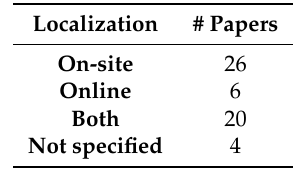
Table 6. Number of papers per